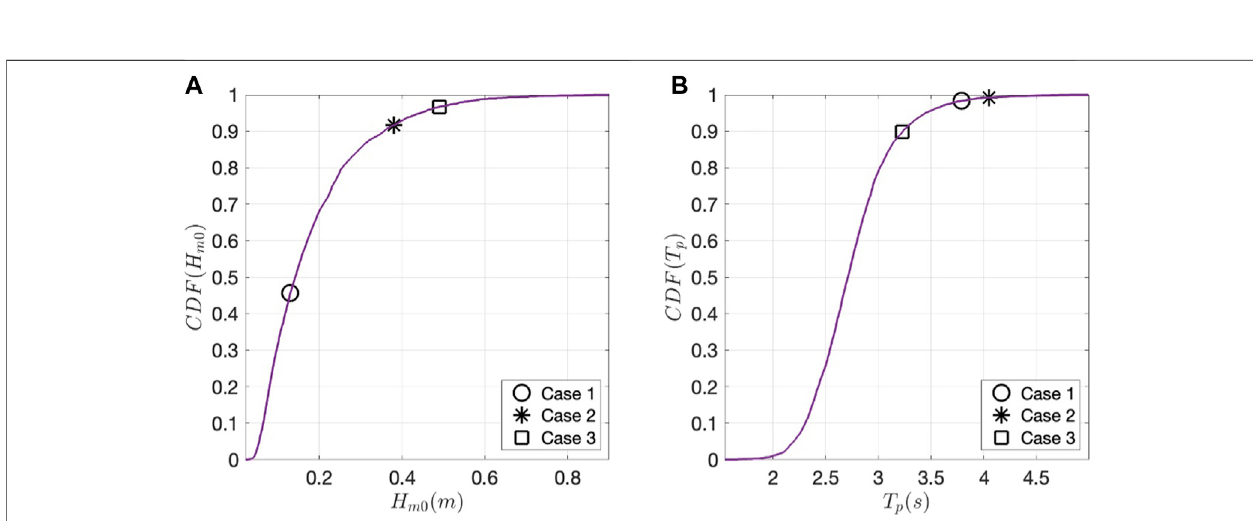
FIGURE 3 | Cumulative probability distribution functions (CDF) for the (A) zero-moment wave height and (B) peak wave period for the year 2018 with the representative cases marked on the fi gure.